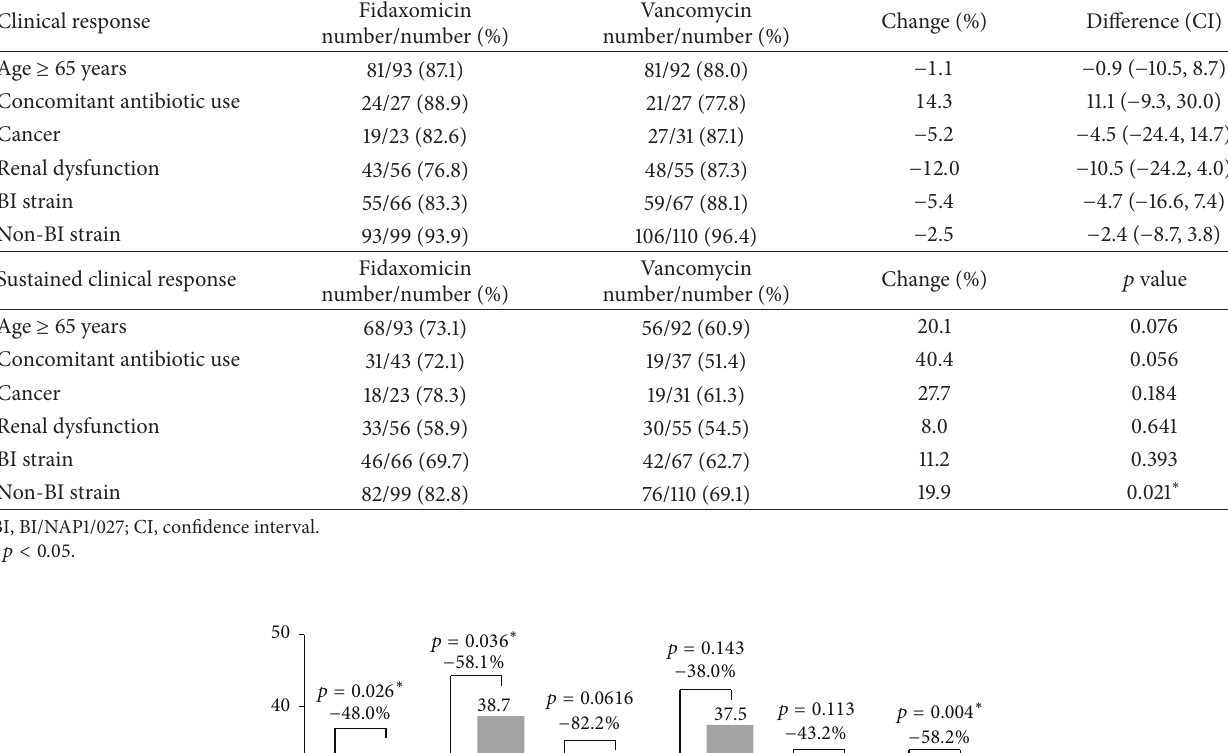
Table 3: Clinical response and sustained clinical response of subgroups within the modified intent-to-treat population. Clinical response